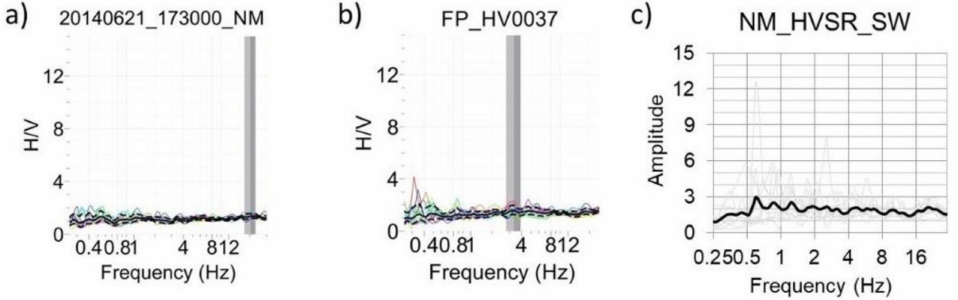
Figure 10. ( a ) HVSR curves from the Tromino single station measurements completed near the NM site; ( b ) HVSR results for the ambient noise recorded by the NM station; ( c ) HVSR curves computed from S-wave windows of earthquake